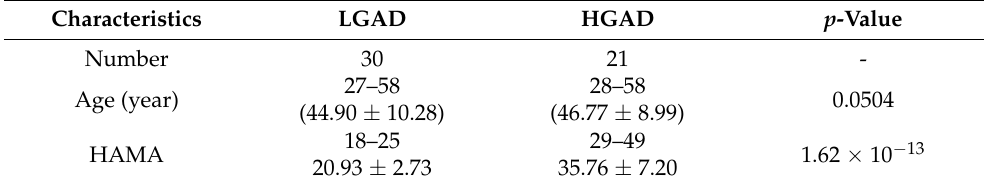
Table 1. Demographic and clinical characteristics of the patients.